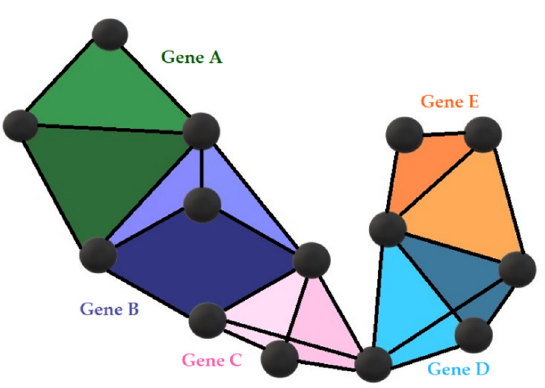
Figure A1. A hypernetwork diagram with a three-dimensional structure of the genes A–E that correlate with the expression of other genes (black spheres). Shared correlations are shown by the black connecting edges.